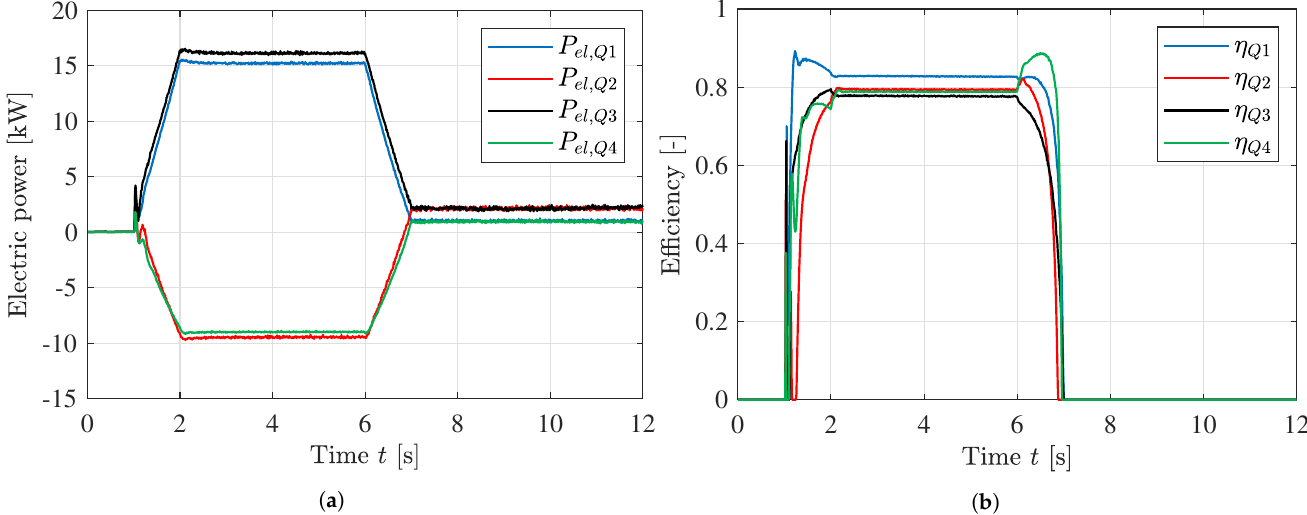
Figure 19. Electric power and efficiency for all four quadrants. Operation in quadrants 1 and 3 consume power, while operation in quadrants 2 and 4 regenerate power. ( a ) Electric power P el from/to the DC-bus; ( b ) Efficiency η of the